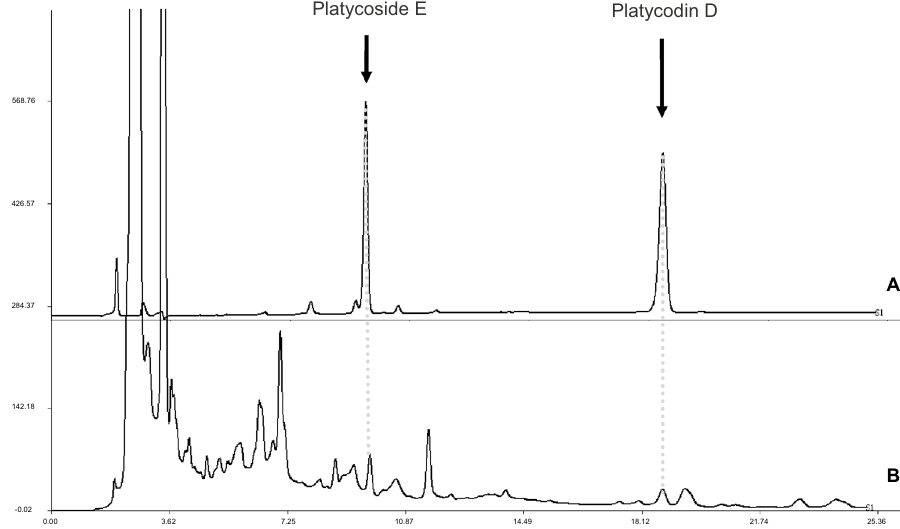
Figure 2. HPLC peak profiles of ( A ) standard products of PD and PE, and of ( B ) the P . grandiflorus extract. The X axis represents the retention time (min) of peaks, and the Y axis represents the height of the peak (mAU).